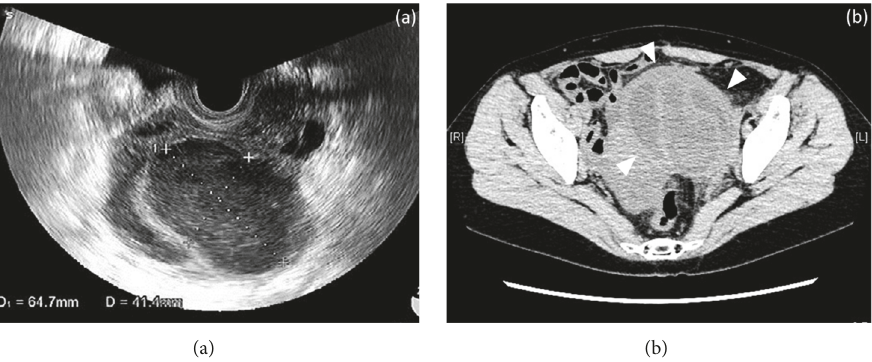
Figure 1: (a) Transvaginal ultrasonography at the first visit of the patient, showing a cystic tumor in the left adnexal area. (b) Pelvic CT on day 8 of hospitalization, showing that the infectious left ovarian cyst had grown to 10 cm (arrowheads).